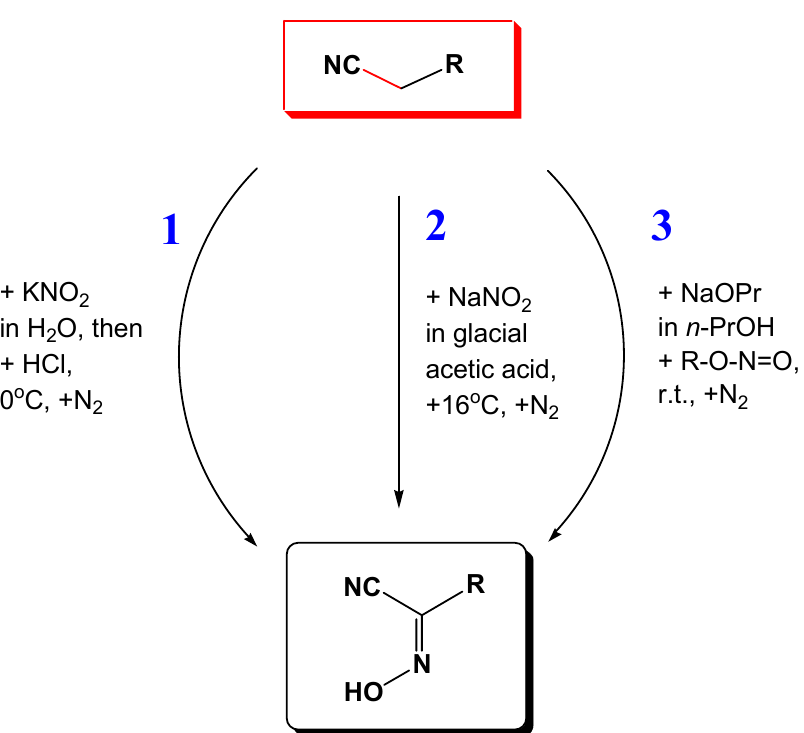
Figure 2. Three developed high-yield routes to